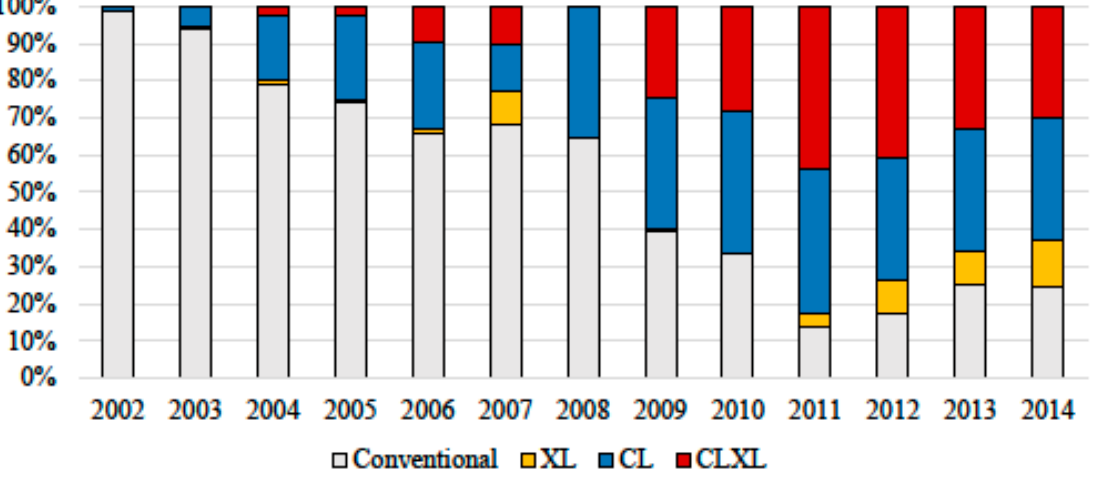
Figure 2. Percent of area planted to Conventional, Clearfield ® (CL), hybrid (XL), and Clearfield ® hybrid (CLXL) rice in the U.S. Mid-South: 2002–2014.